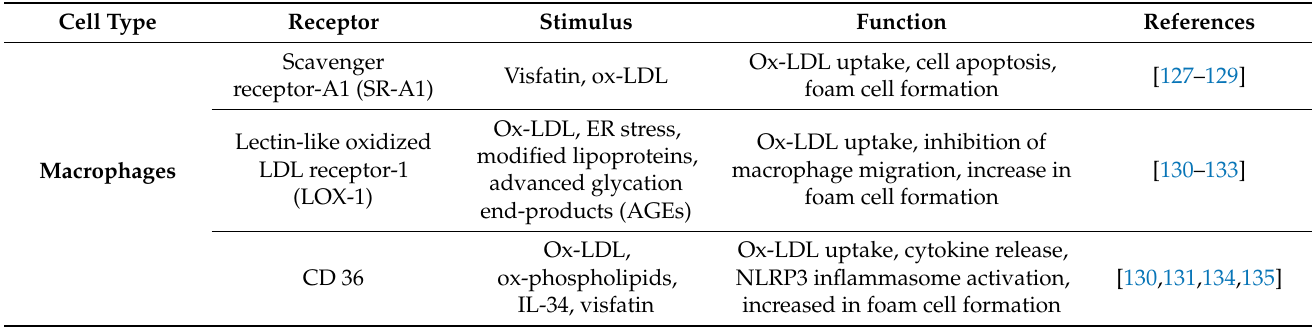
Table 1. Main scavenger receptors involved in